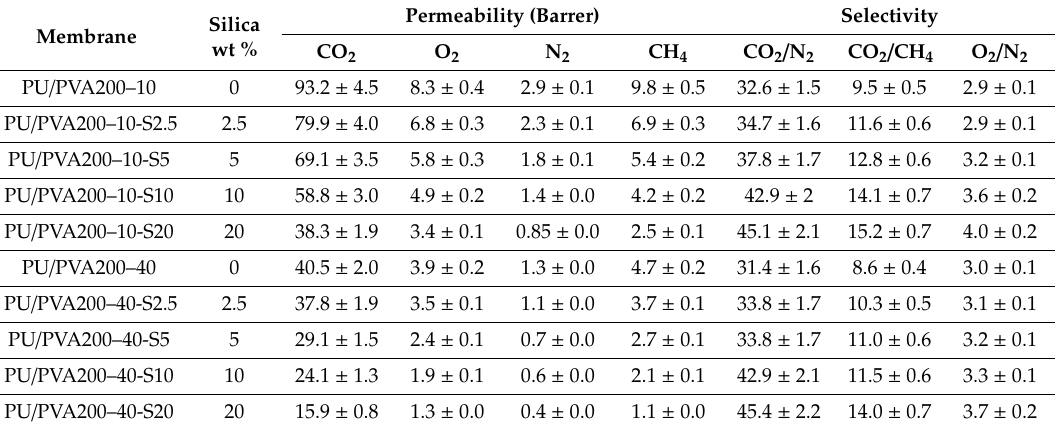
Figure 6. Comparison of the CO 2 /N 2 separation performance of the ( a ) PU/PVA200 blends and ( b ) PU/PVA200/silica MMMs compared to Robeson’s upper bound. Table 2. Separation properties of CO 2 , O 2 , N 2 , and CH 4 through PU / PVA200 / silica Table 3. Mixed gas separation properties of the membranes at 4 bar and 25 °C.